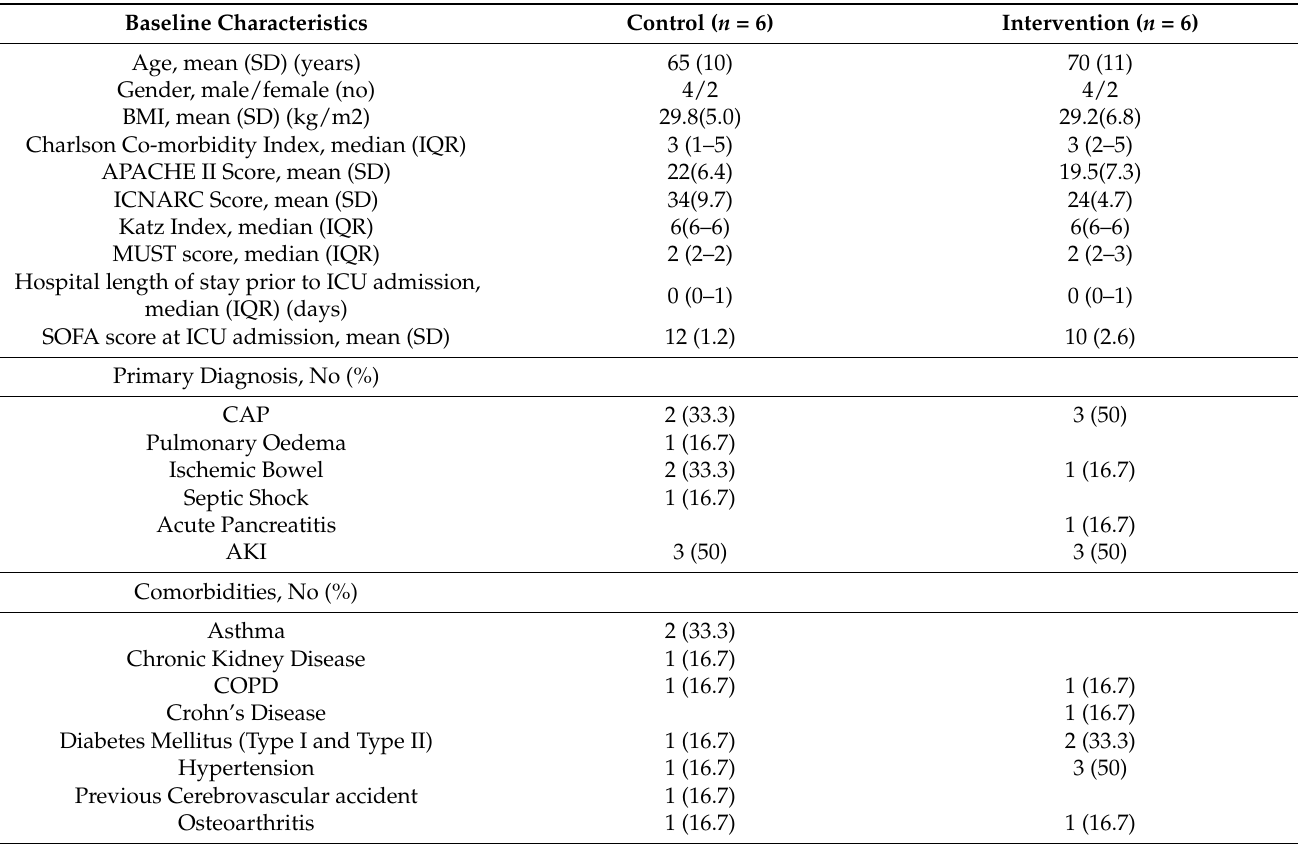
Table 1. Baseline characteristics of the control and intervention